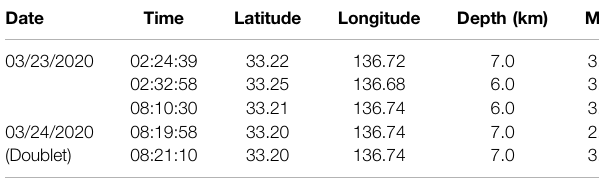
TABLE 1 | sVLFE catalog in March 2020.